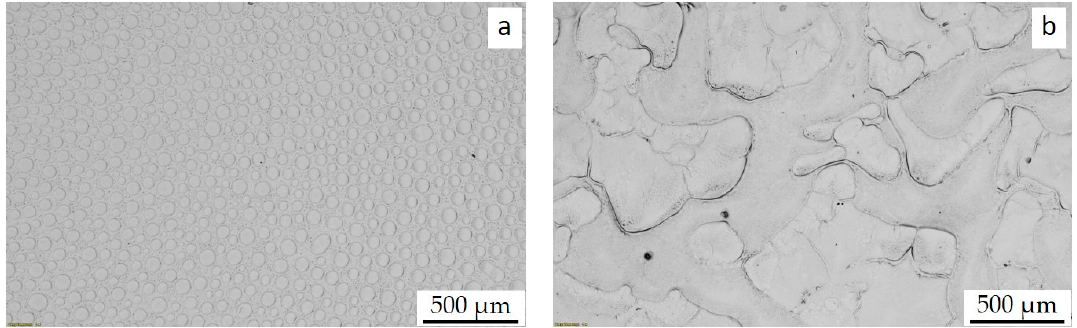
Figure 3. TLM images of PS / PB blends made from ( a ) toluene and ( b ) chloroform, prepared on glass substrates.